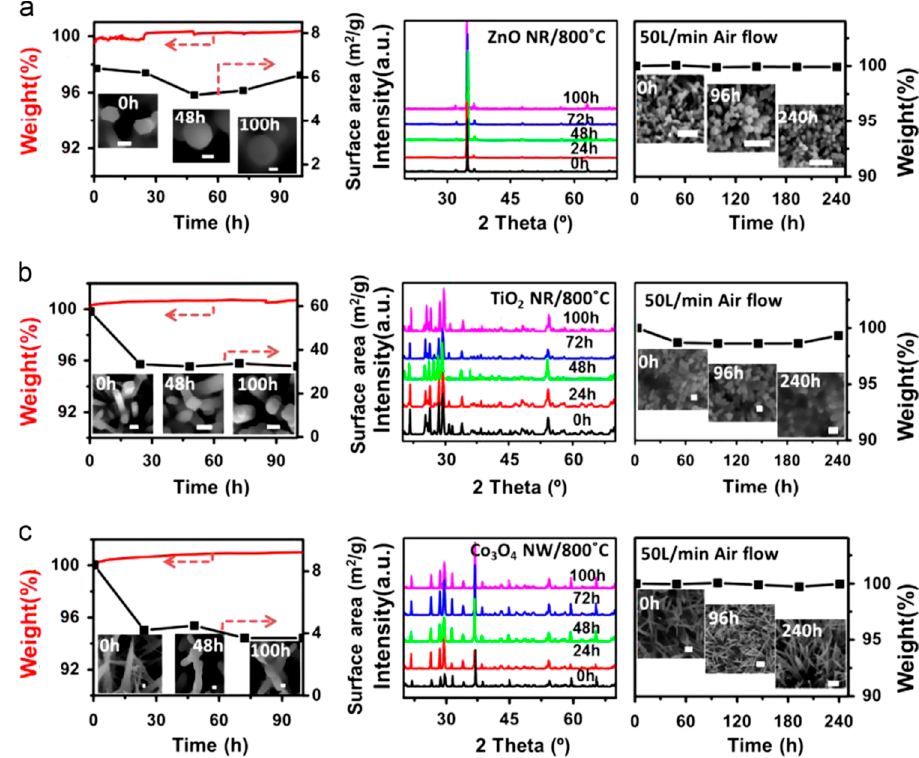
Figure 13. Thermal and mechanical robustness of metal oxide nano ‐ array based monolithic catalysts in ambient atmosphere. ( a ) 1 ‐μ m ZnO nanorod array grown on stainless steel monolith; ( b ) 1 ‐μ m TiO 2 nanorod array grown on cordierite monolith; ( c ) 8 ‐μ m Co 3 O 4 porous nanowire array grown on cordierite monolith. Reprinted with permission from [36], Copyright Elsevier, 2013.